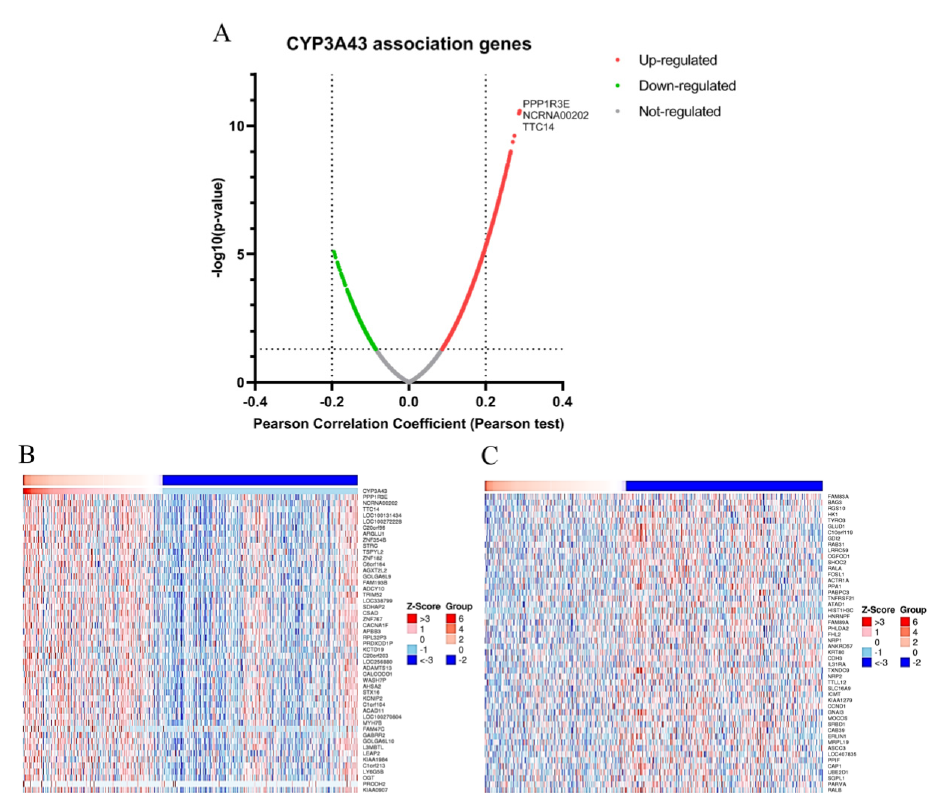
Figure 5. CYP3A43 co-expressed genes in LUAD. ( A ) Volcano plot showing the CYP3A43 co-expressed genes. ( B , C ) Heatmaps showing the top 50 significant genes positively ( B ) and negatively ( C ) associated with CYP3A43 in LUAD.